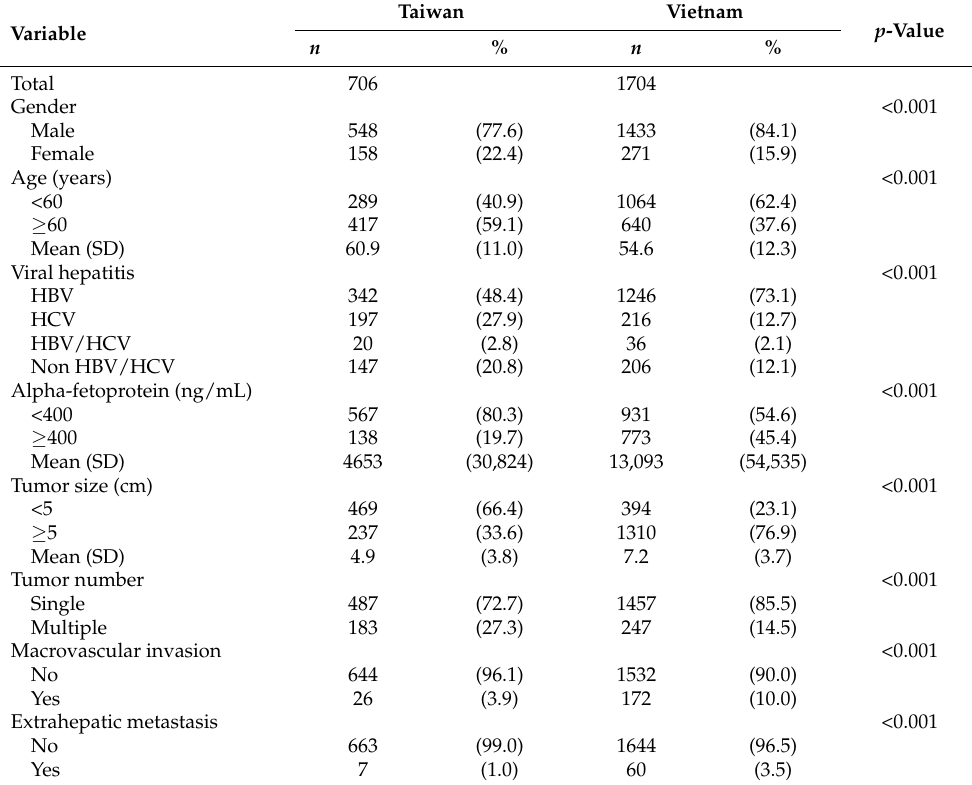
Table 1. Comparison of patient and tumor characteristics.